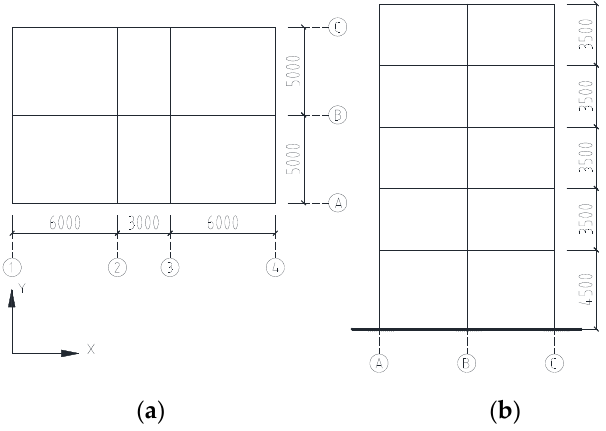
Figure 8. The plan and elevation of the structure (unit: mm). ( a ) plan; ( b ) elevation.